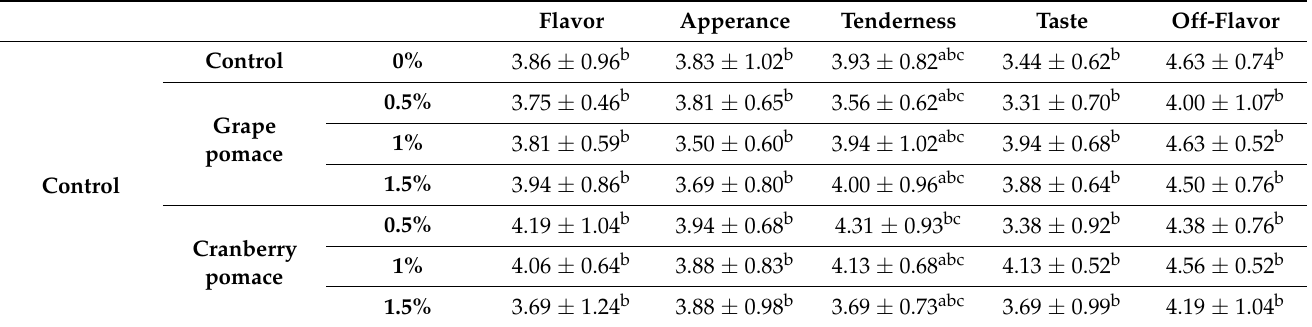
Table 1. Changes in sensory profile by way of flavor, appearance, tenderness, and taste across the various marinated oven-grilled chicken breast meat samples compared to the